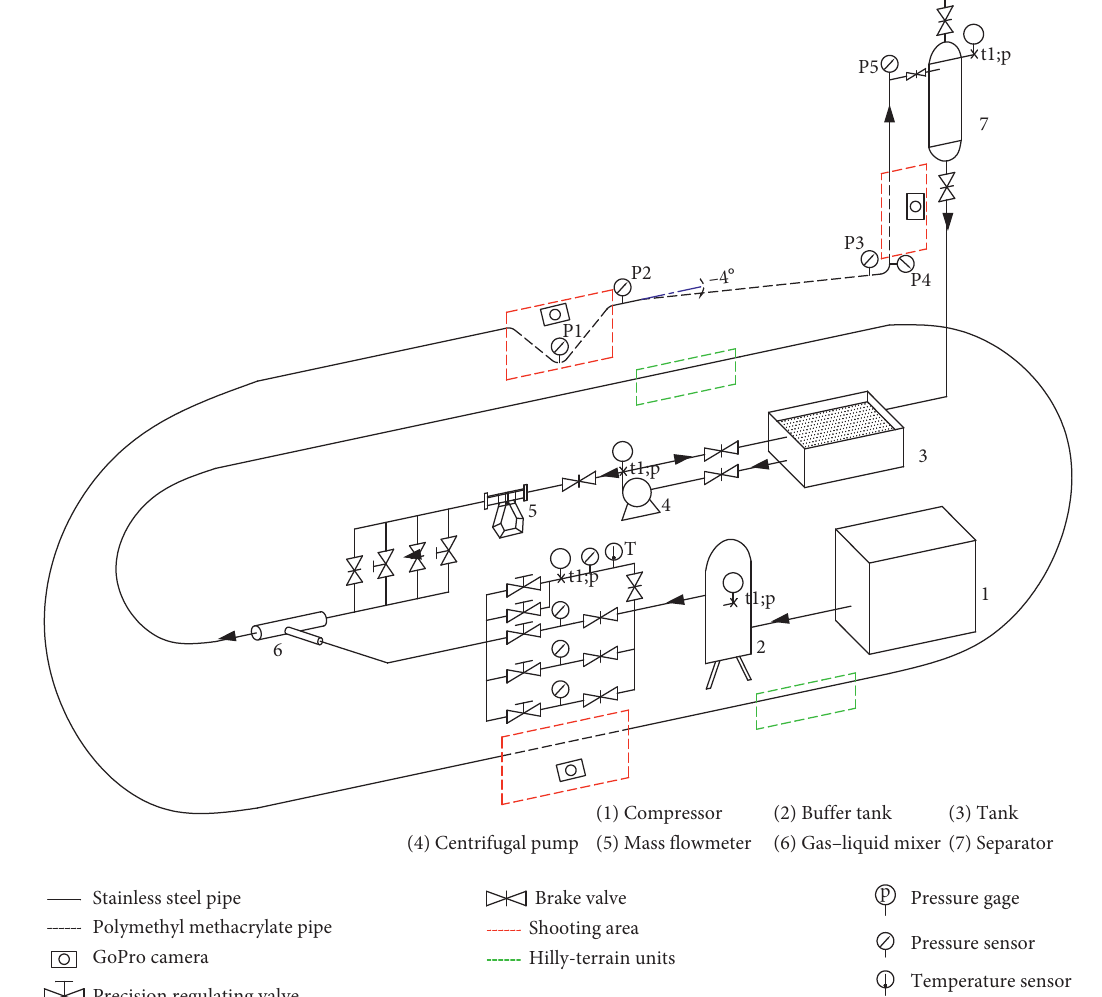
Figure 1: Experimental hilly-terrain pipeline-riser system.